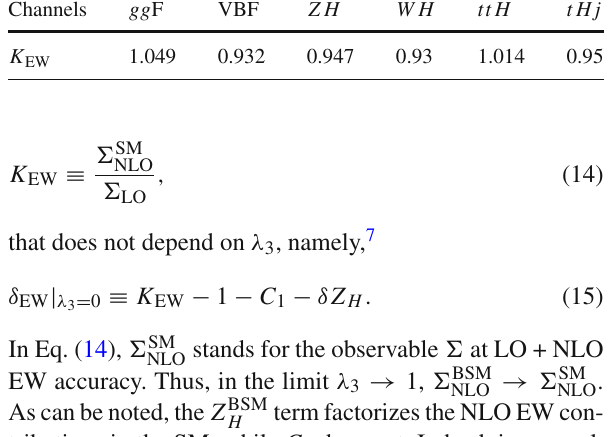
Table 2 NLO EW K -factors for different production channels